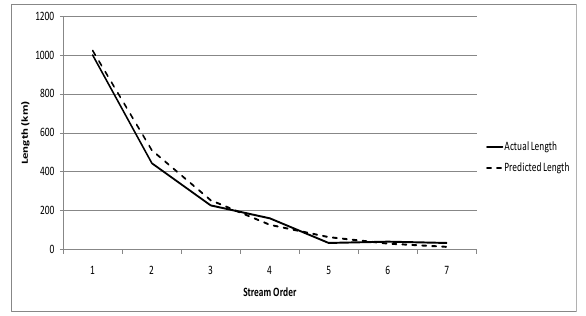
Figure 9, Upper Oaky Creek – Actual v Predicted Waterways Table 4, Upper Oaky Creek – Actual v Predicted